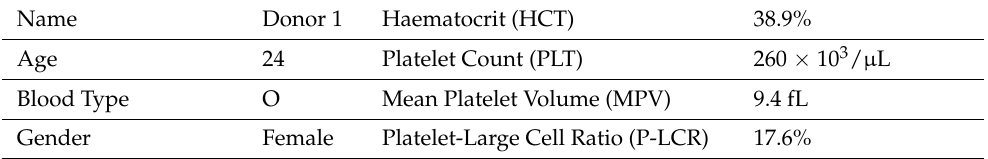
Table 1. Blood profile for healthy donor showing platelet indices relevant to platelet